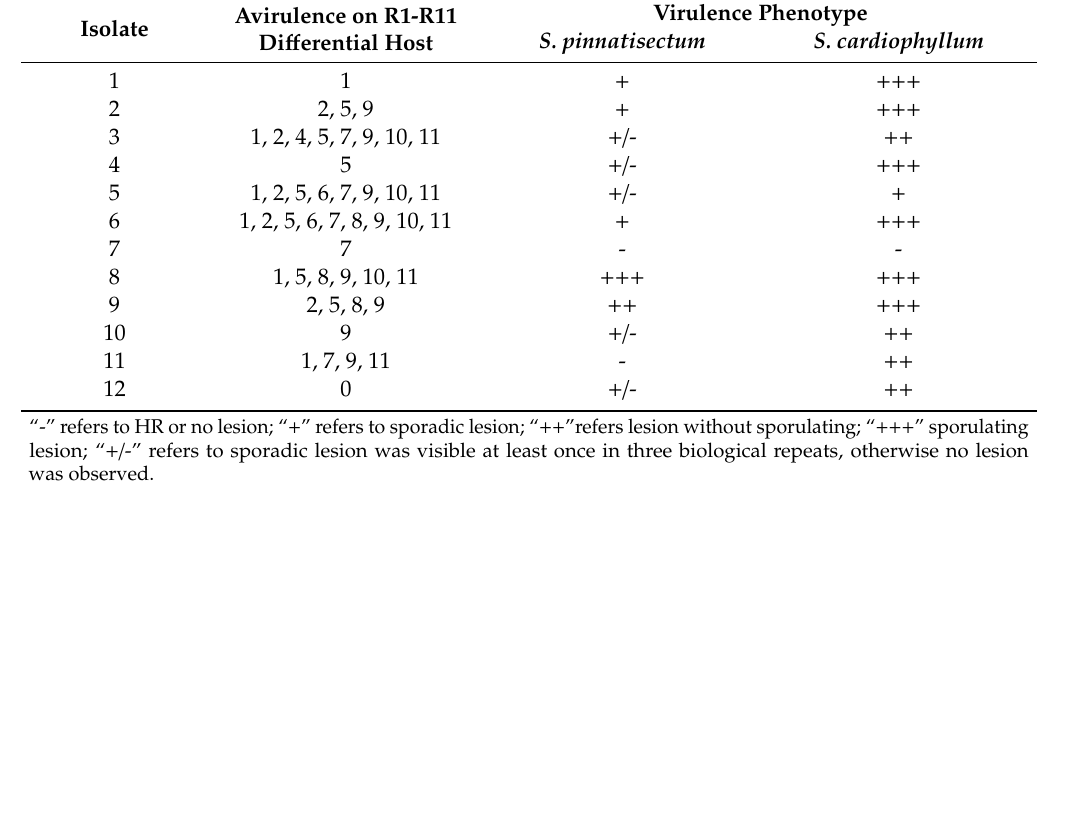
Table 2. Solanum pinnatisectum and Solanum cardiophyllum show distinct patterns of the phenotype challenged by di ff erent isolates of Phytophthora infestans with a di ff erent ability to infect the di ff erential set of potato carrying R1 to R11